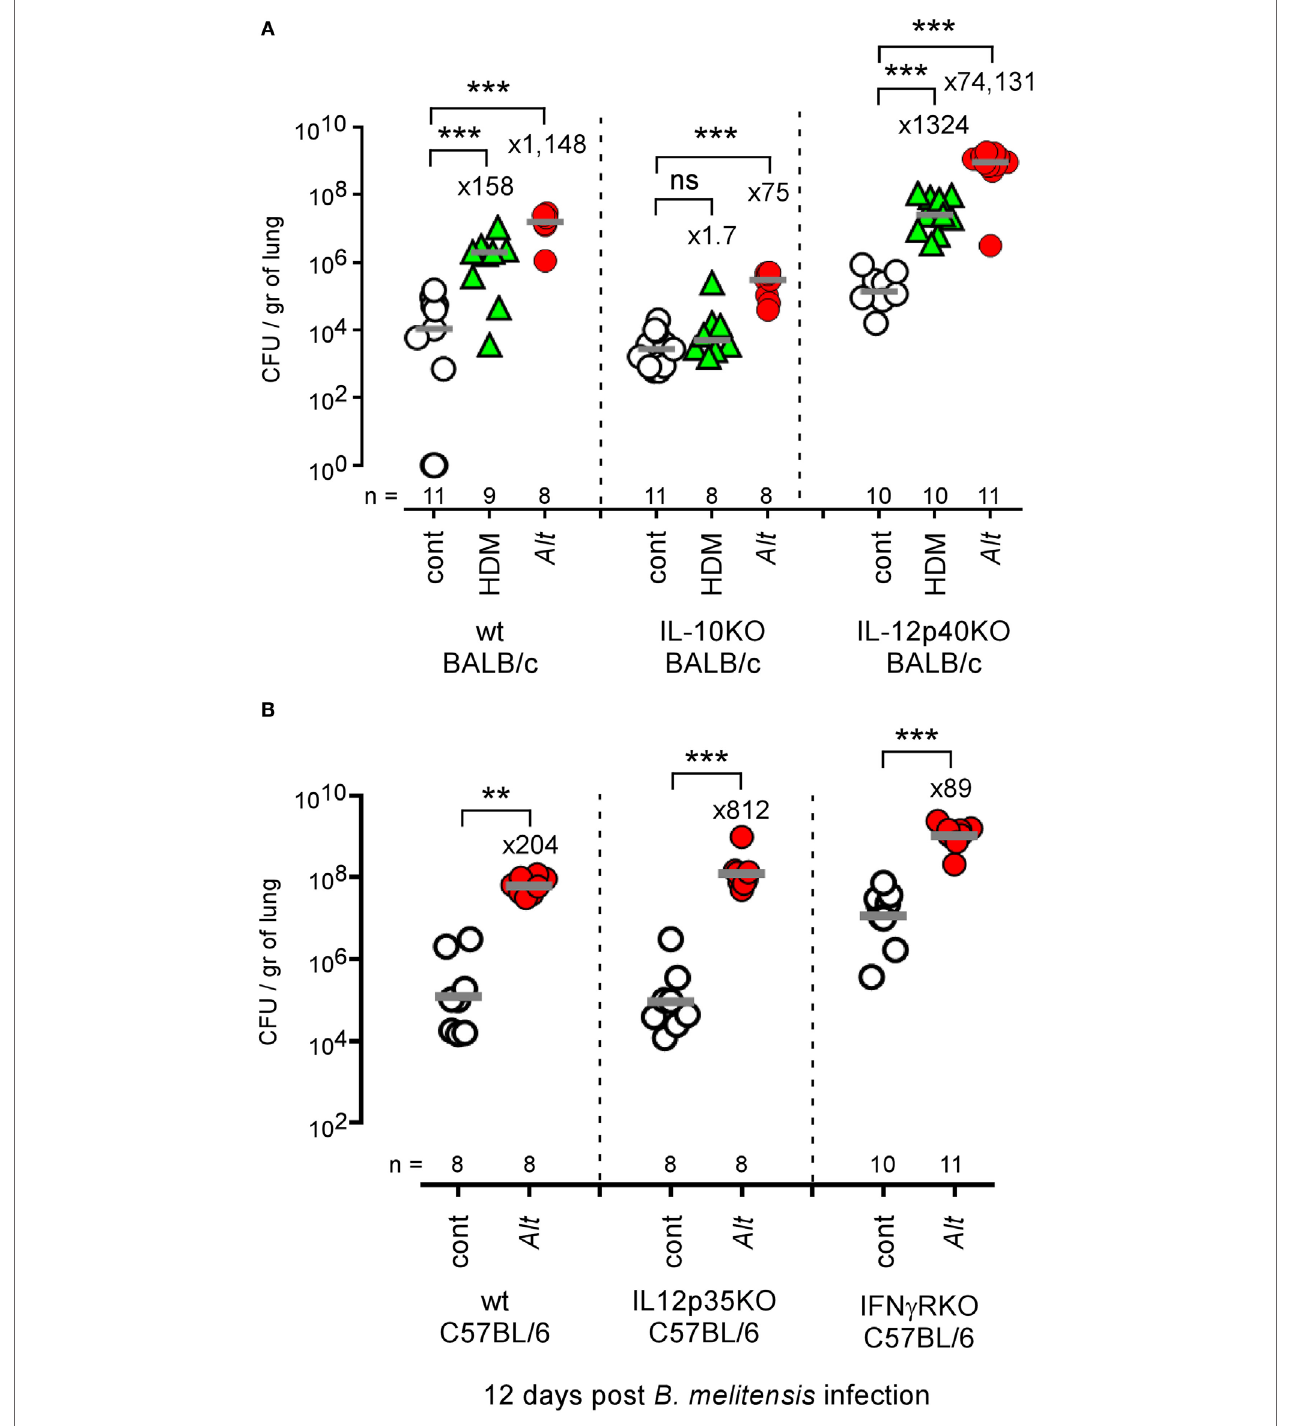
FigUre 8 | Impact of IL-10 and IL-12 deficiency on asthma-induced Brucella susceptibility. (a) Wild-type, IL-10 − / − , and IL-12p40 − / − BALB/c mice received repeated i.n. administration of phosphate-buffered saline (PBS) or Alt before i.n. infection with 2 × 10 4 CFU of mCherry- Brucella melitensis . The mice were sacrificed at 12 days post infection. The data represent the CFUs per gram of lung. (B) Wild-type, IL-12p35 − / − , and IFN- γ R − / − C57BL/6 mice received repeated i.n. administration of PBS or Alt before i.n. infection with 2 × 10 4 CFU of mCherry- B. melitensis . The mice were sacrificed at 12 days post infection. The data represent the CFU/gr of lung. Horizontal gray lines represent the medians. n denotes the number of mice used for each lineage. These results are representative of at least three independent experiments. ** p < 0.01, *** p <